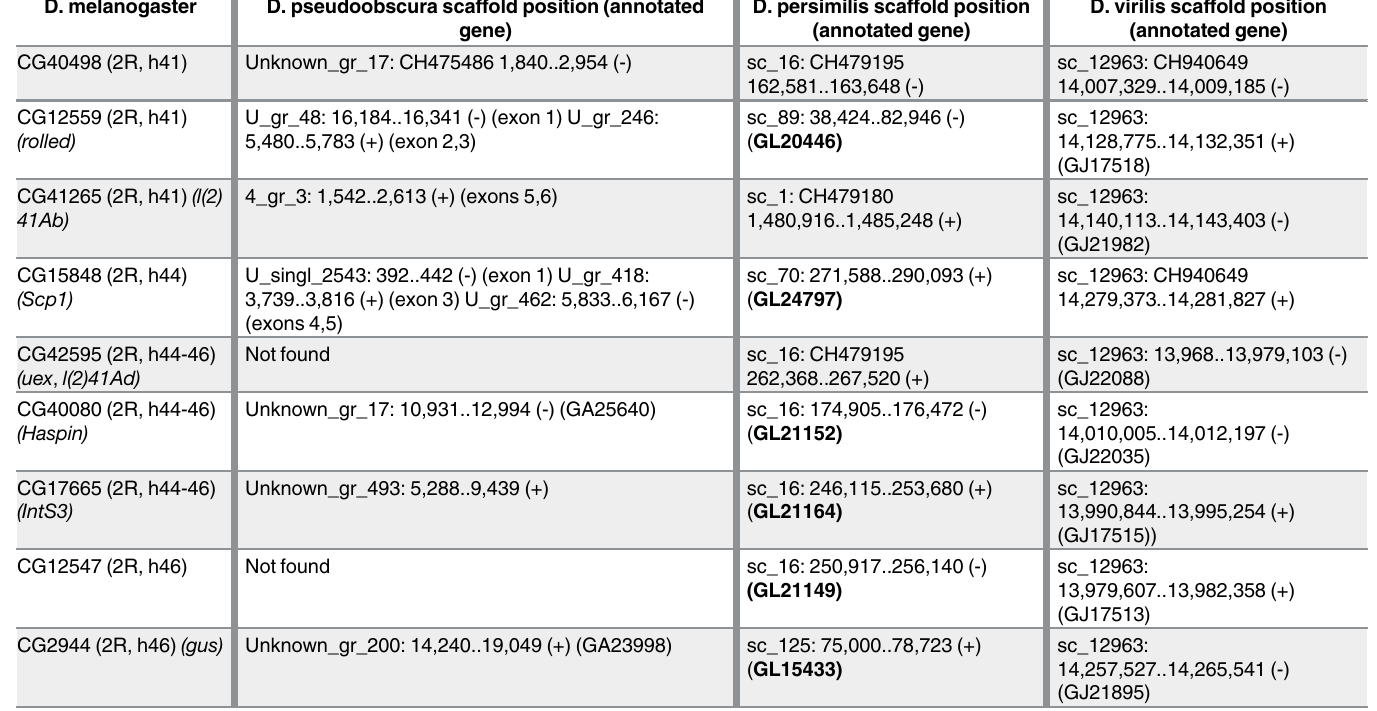
Table 2. List of D . melanogaster 2R-HET genes analysed in D . pseudoobscura , D . persimilis and D . virili s. D.